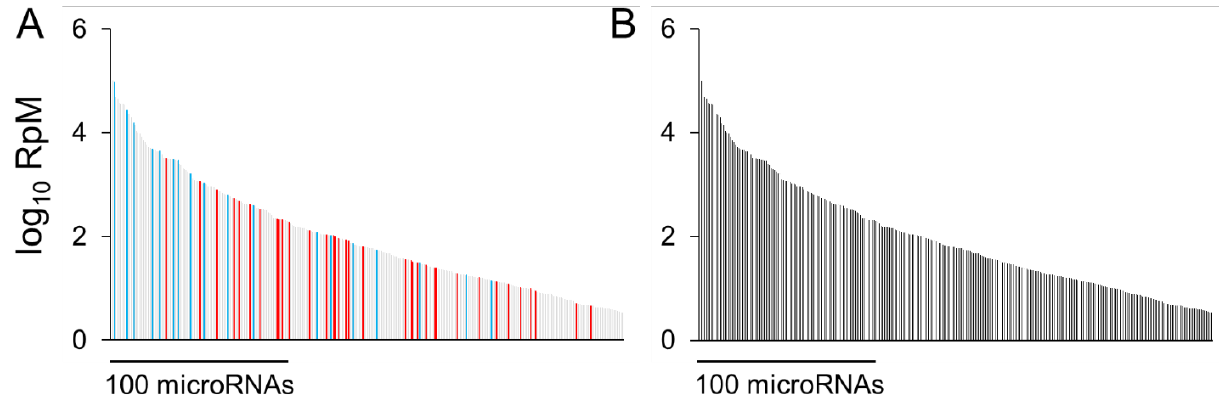
Figure 1. ( a ) 300 microRNAs expressed in mouse hearts, plotted according to abundance (log of Reads per Million microRNA reads, RpM), in descending order (light gray bars). 10 Red bars denote microRNAs upregulated by at least 25%, false discovery rate (FDR) < 0.02, after 1 week pressure overload, as previously described [34]; blue bars denote microRNAs downregulated under the same conditions. ( b ) MicroRNAs stably expressed (not regulated) after 1 week pressure overload ( i.e. , the light gray bars from ( a )). For both ( a ) and ( b ), data are redrawn from [34] and NCBI GEO accession GSE56891. The most abundant 100 microRNAs represent 99% of the total cardiac microRNA content